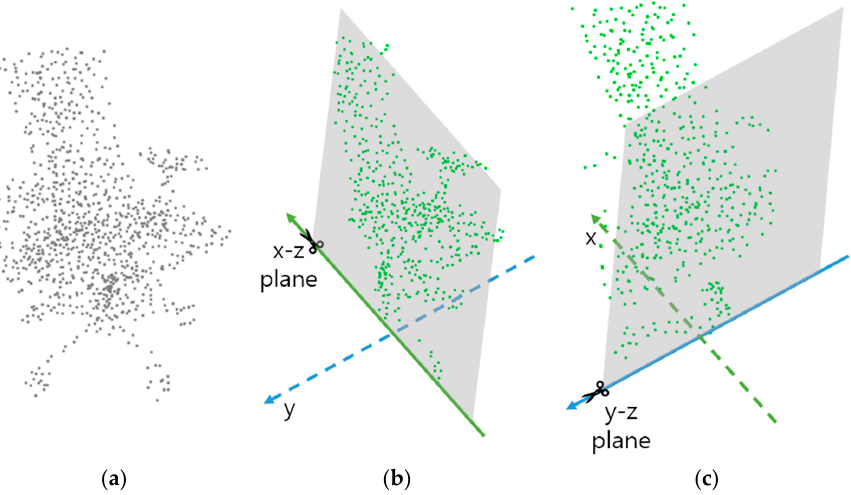
Figure 3. Pseudo-label voting process utilizing recycling max pooling module.